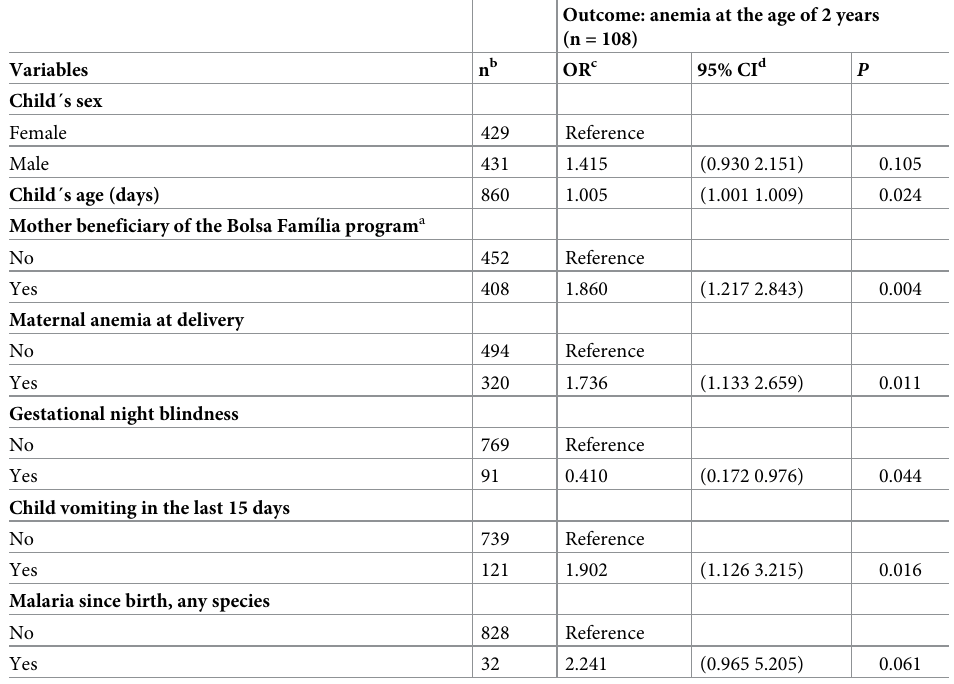
Outcome: anemia at the age of 2 years (n = 108)